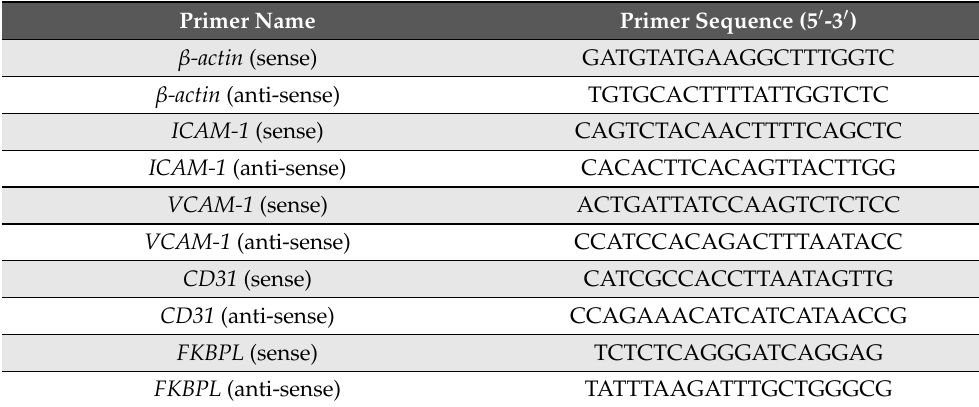
Table 1. qPCR primers and nucleotide